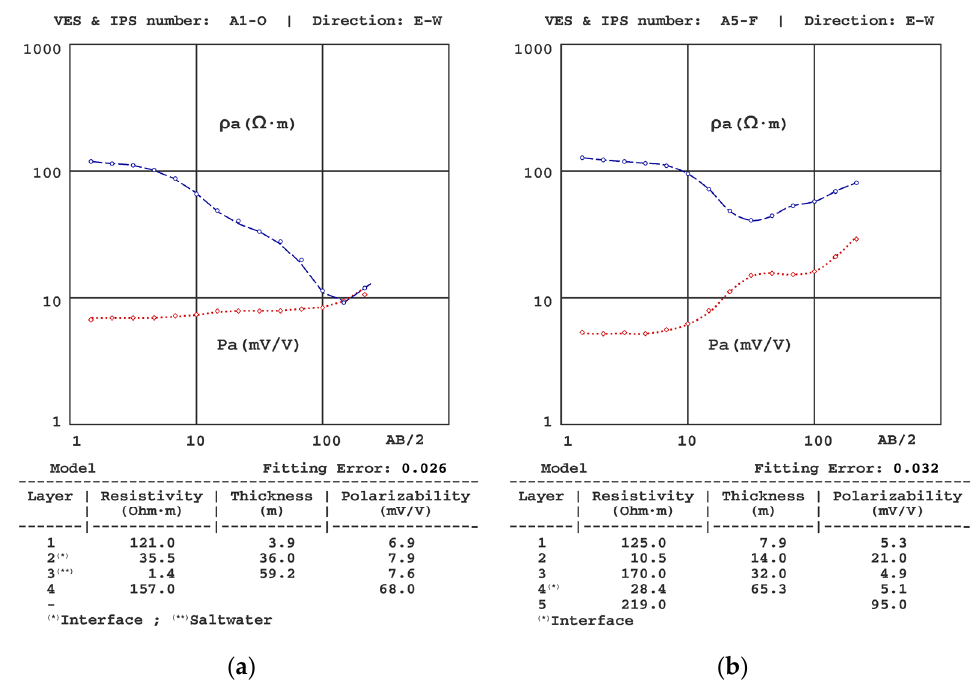
Figure 6. Results of the ( a ) A1-O VES-IPS obtained mid-autumn and ( b ) A5-F VES-IPS obtained late winter. late winter.